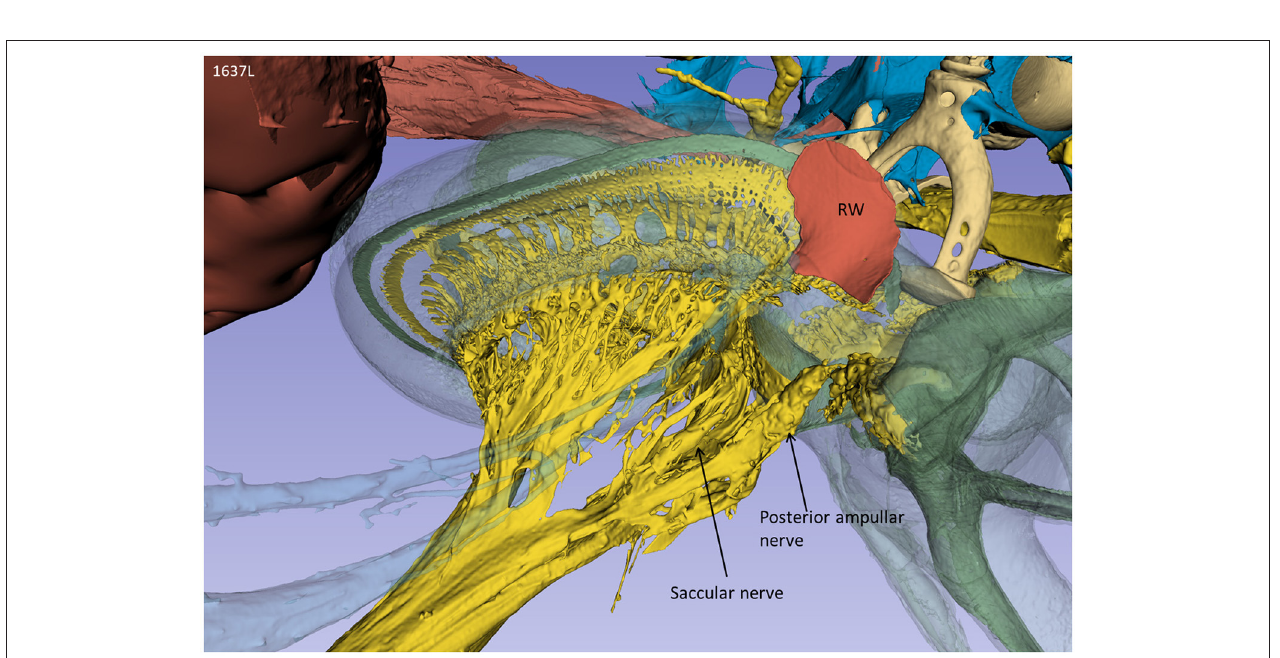
FIGURE 3 | A posterior-inferior view of the specimen shown in Figure 2 . The relationships between the RW and the posterior ampulla and saccular nerves are shown. The distance between the middle of the RW and the middle part of the posterior ampulla was 2.6mm.